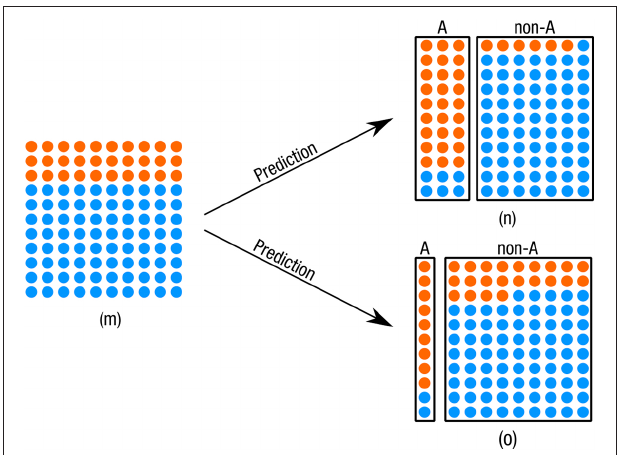
FIGURE 1 | By varying the precision of the predicted group non-A one can vary the size of the group A and retain the same precision for group A. Orange dots are in group A (30%), blue dots are not (70%). The two predictions (n) and (o) both have precision of 80 % for group A, yet different accuracy [88% for (n) and 76% for (o)], and